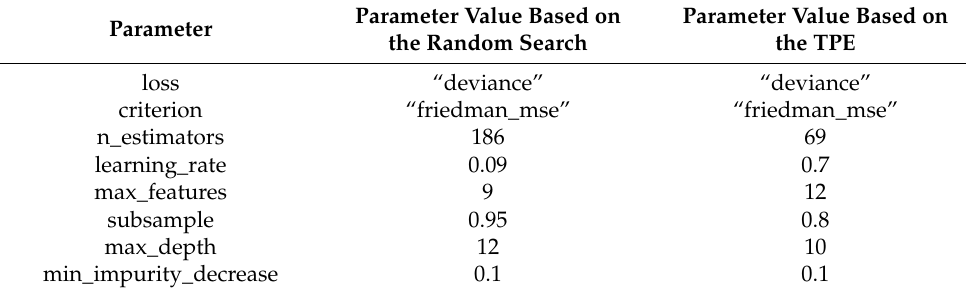
Table 4. The Optimized parameters for the GBDT model.